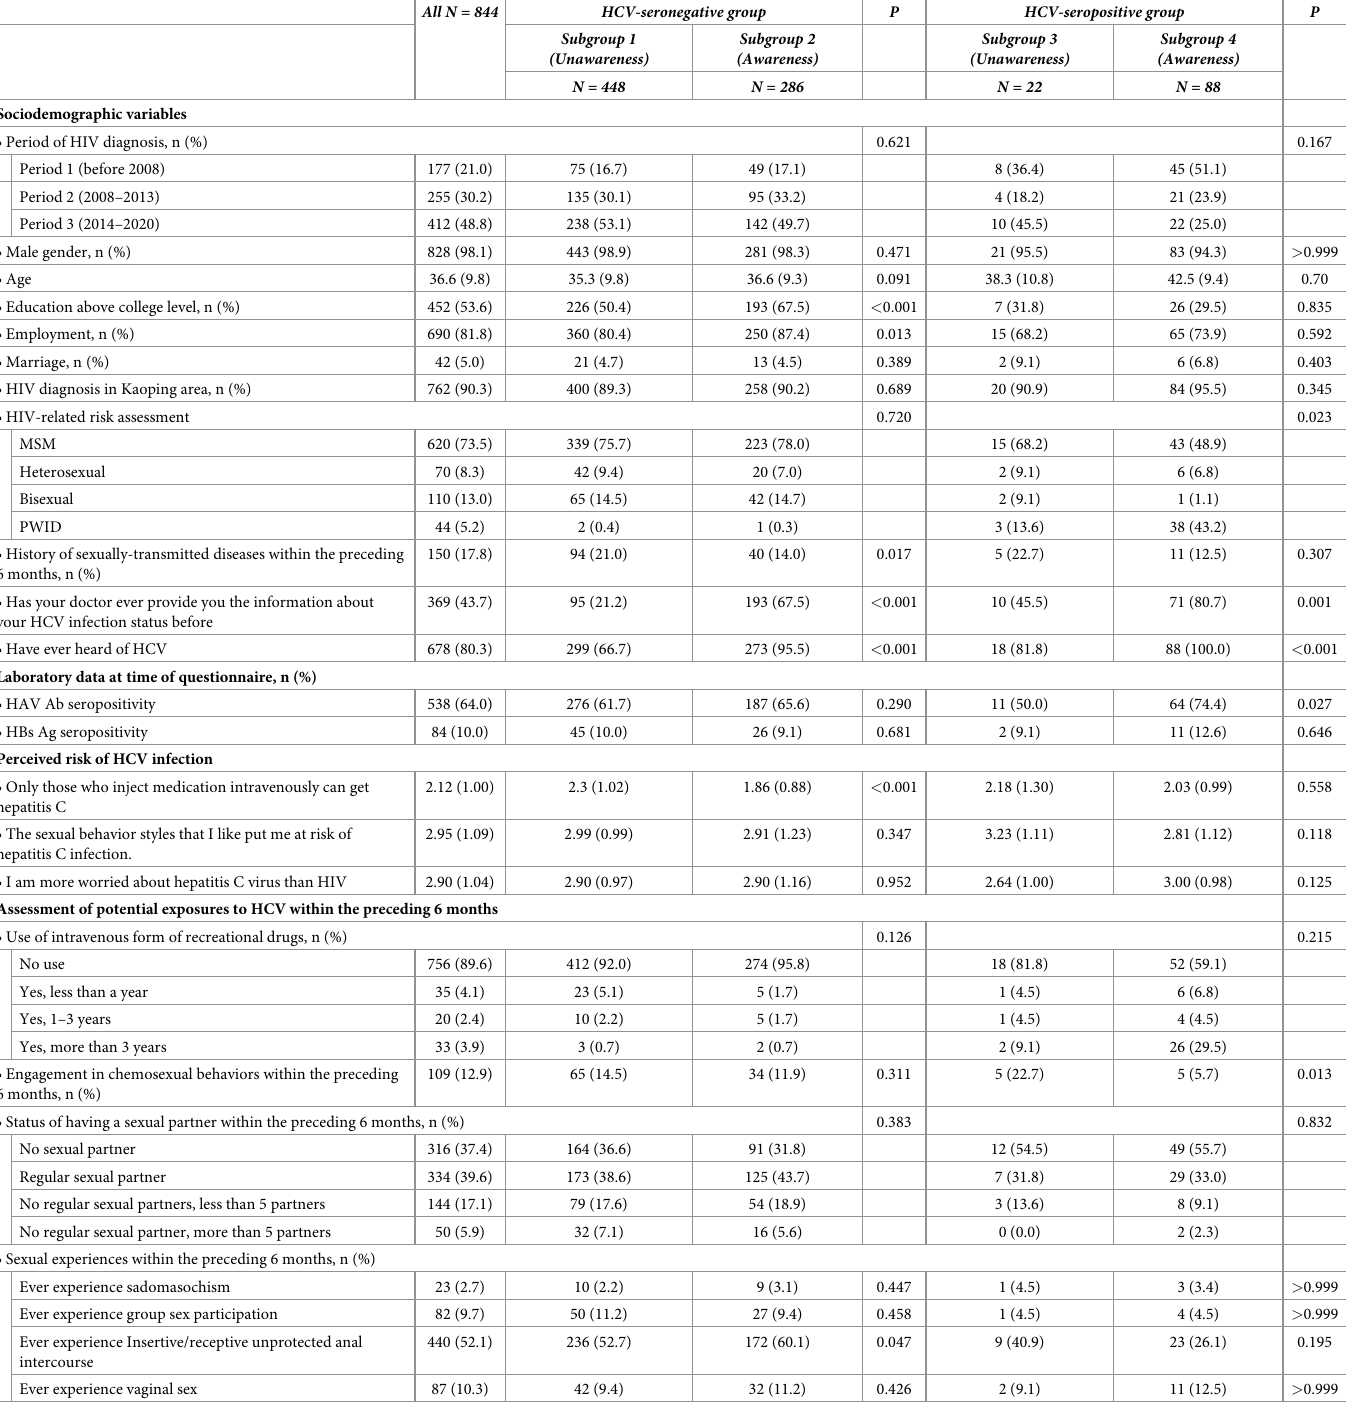
Table 1. Comparison of sociodemographic characteristics of 844 PLWH between those with and without awareness of their HCV infection status, stratified by HCV serostatus.